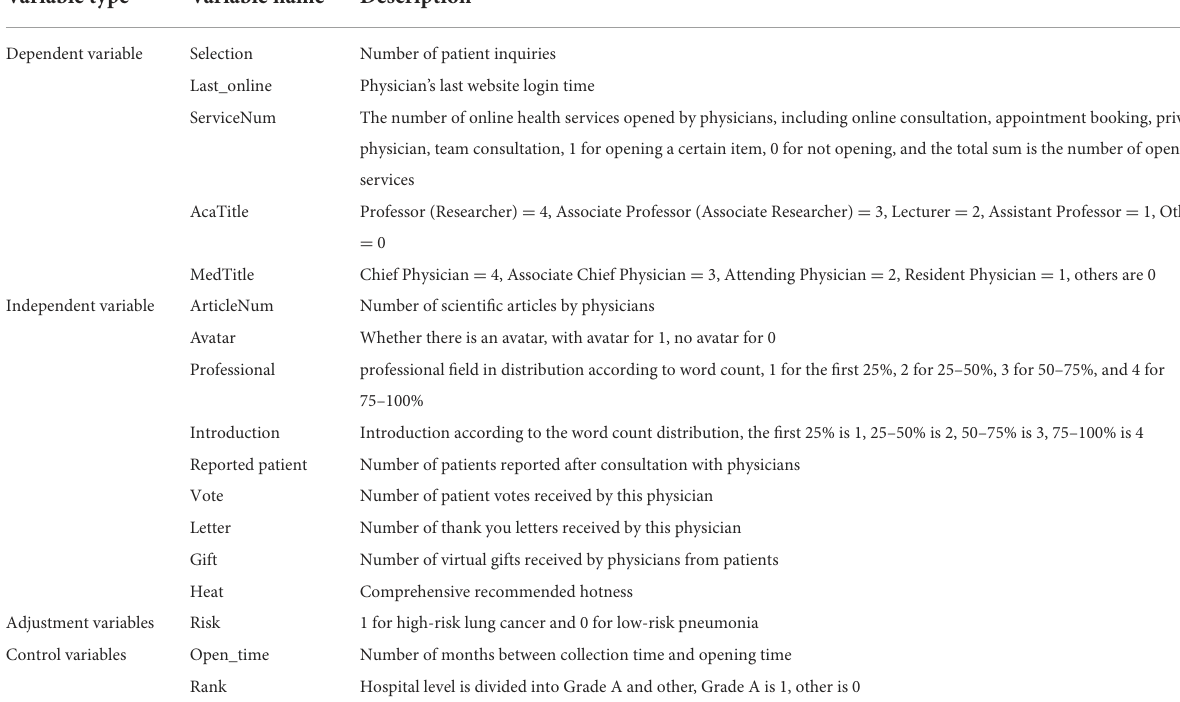
TABLE 1 Description of